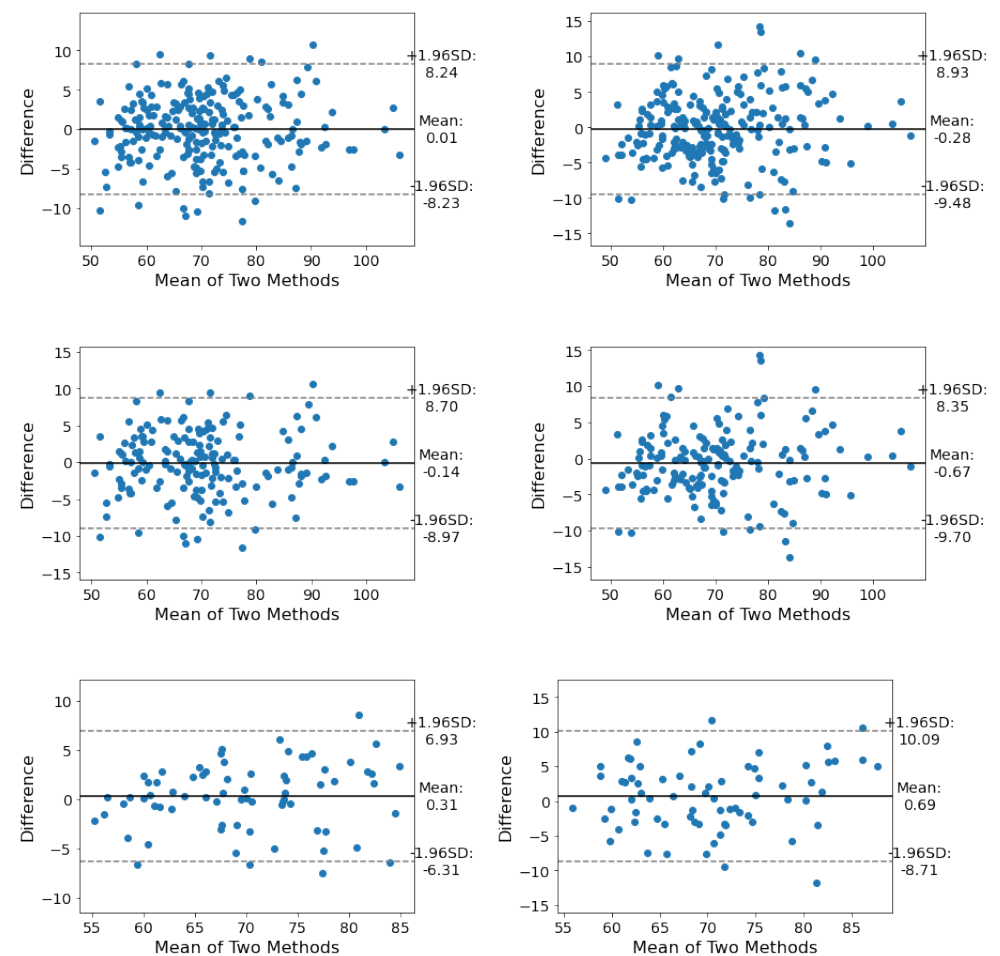
Figure 6. The LoA between the heart rate estimation of Se 1 ( left ) and Se 2 ( right ) under the thoracic and abdominal regions. From top to bottom: LoA of all subjects, males, and females. For females, Se 1 showed significantly better agreement with the reference